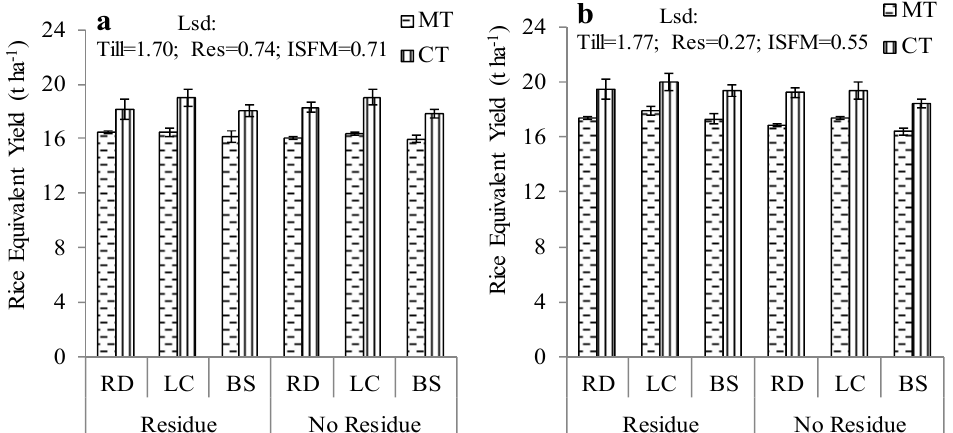
Figure 2. Management impacts on rice equivalent yield (REY) for two consecutive years ( a ) 2017 and ( b ) 2018.